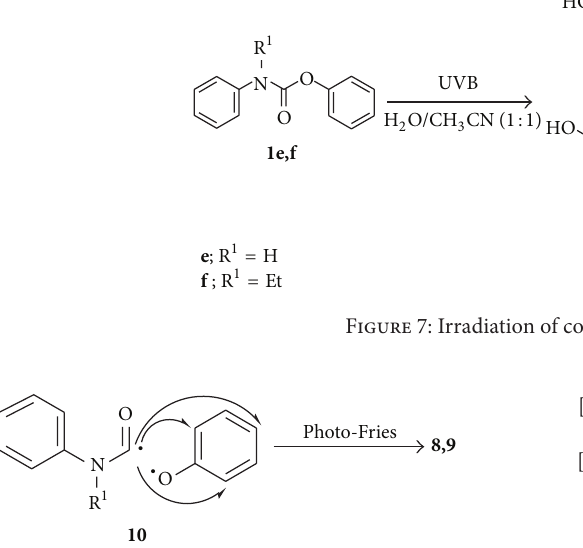
Figure 8: Suggested pathways for the photoproducts 8 and 9